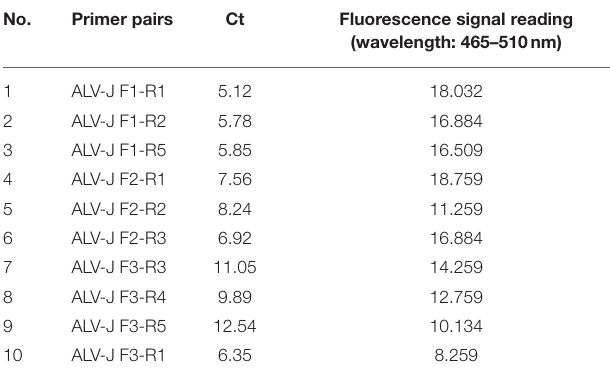
TABLE 2 | Screening of the best real-time RPA primer pairs.